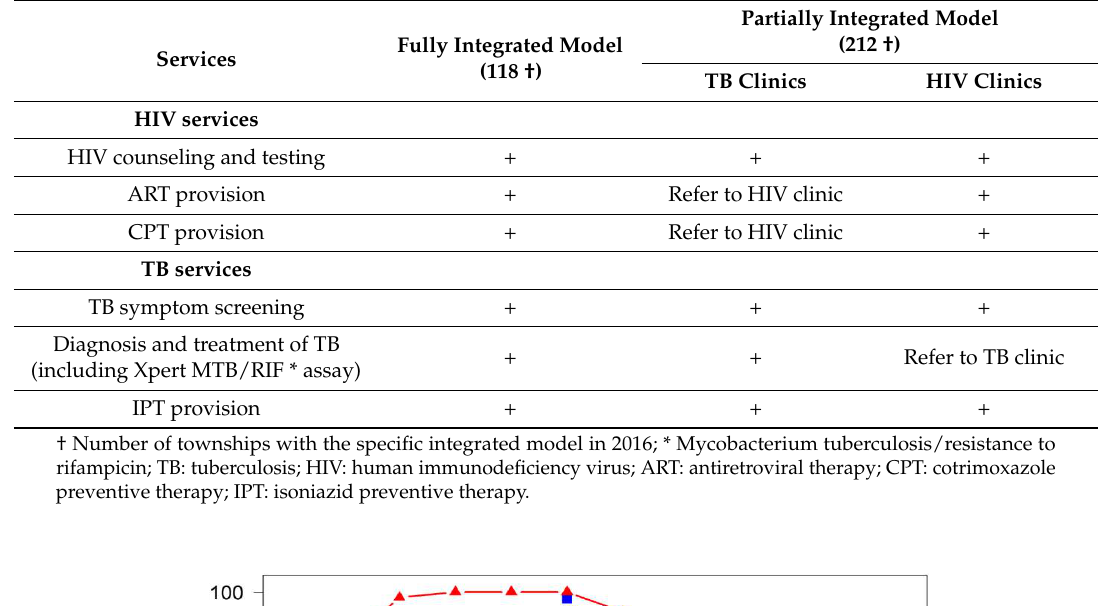
Table 2. Availability of Services for TB/HIV co-infected patients.